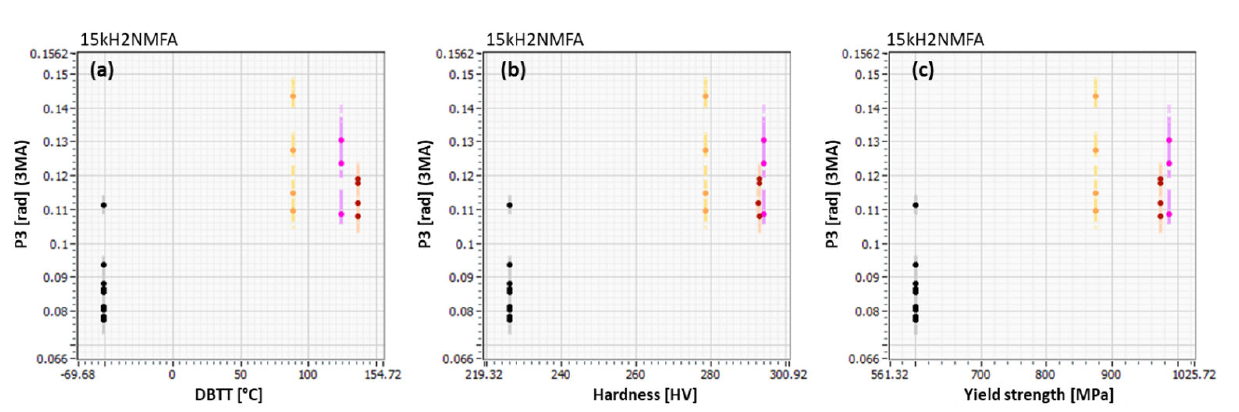
Figure 14. Dependency of the MAT descriptor on the DBTT ( a ), hardness ( b ), and yield strength ( c ) of western RPV material A508 Cl.2.